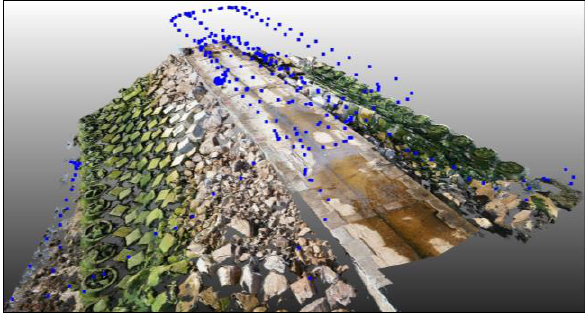
Figure 18 . Photogrammetric model of the dike in Cherbourg Photogrammetric surveys on the CHERLOC projects will still be ongoing in 2022 on both sites. It will be interesting to analyse the displacements after the seasonal winter storms in those